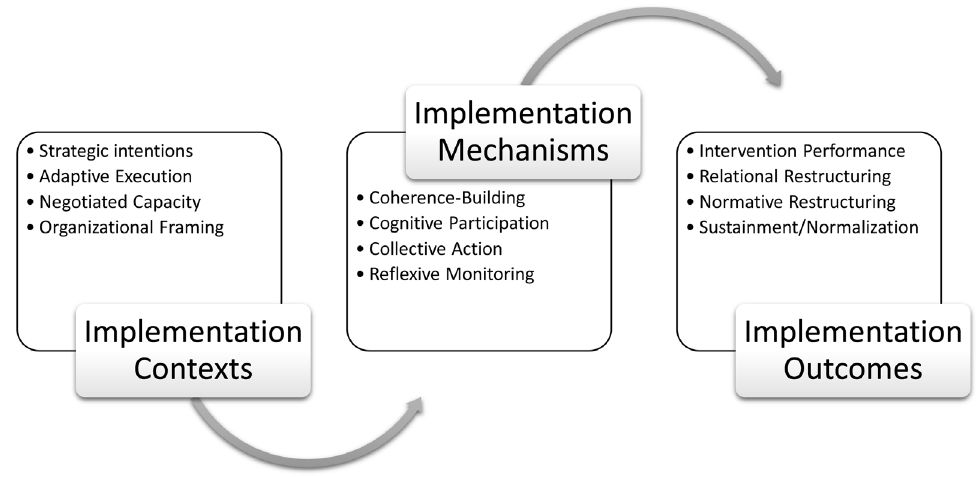
Figure 1. Normalization Process Theory (NPT) constructs and implementation